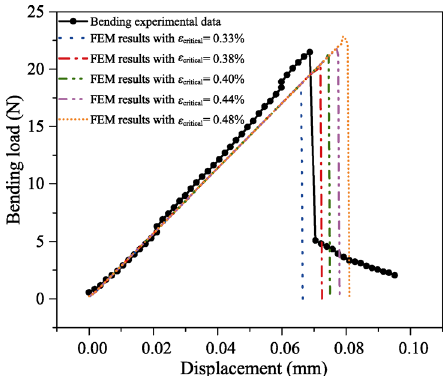
Fig. 9 Estimation of the critical cracking strain of GYbZ coating sample by FEM, comparing with the experimental